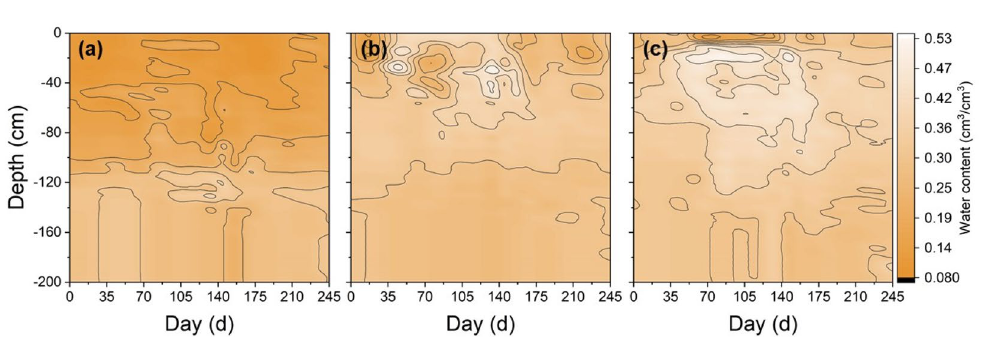
Figure 5. Contour map of soil water of farmland ( a ), LT grassland ( b ) and AS land ( c ) from 24 October, 2015 to 25 June, 2016.